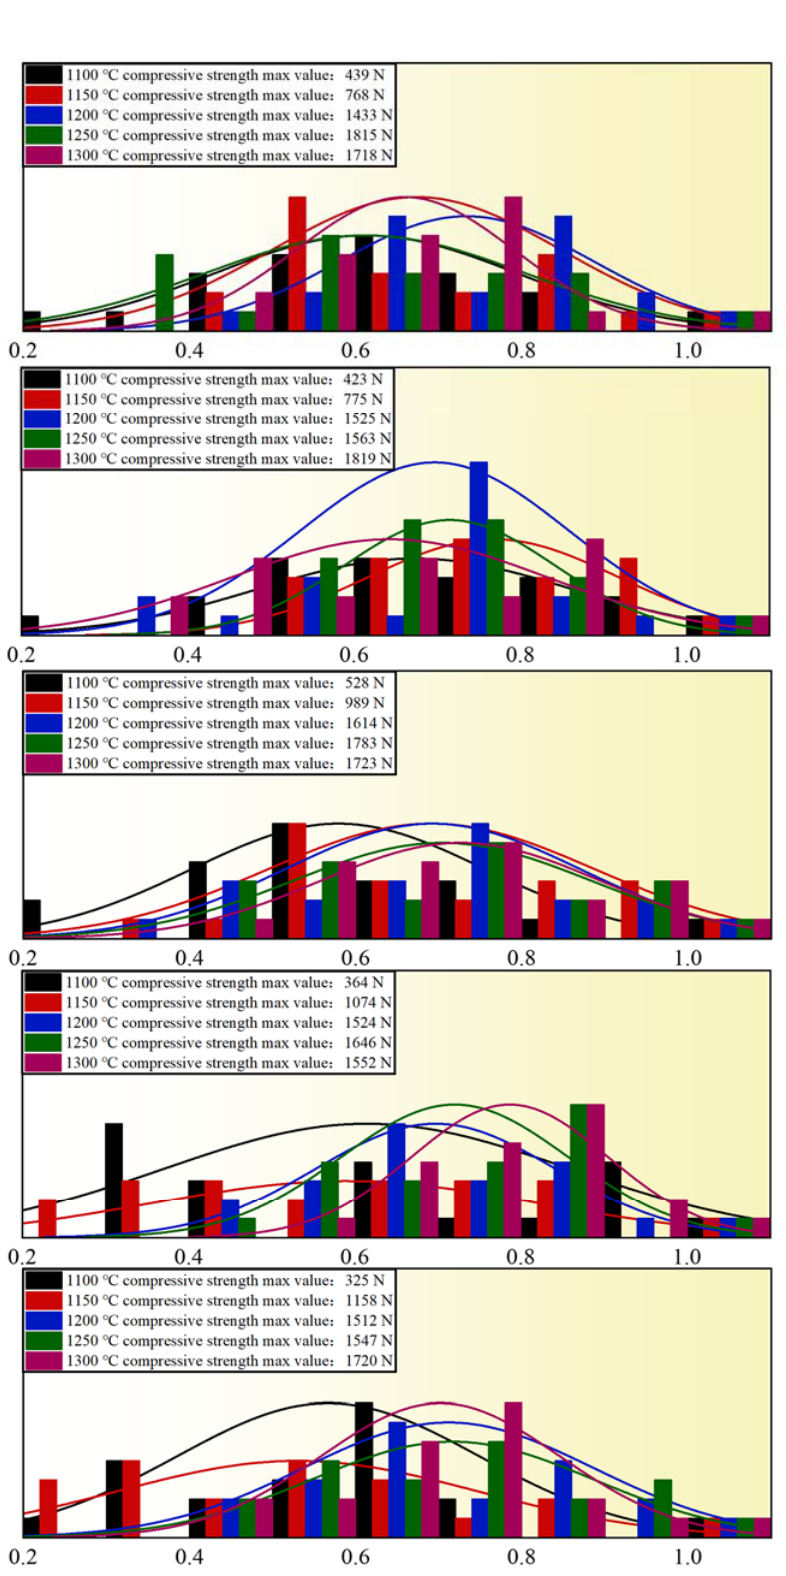
Figure 7. Effect of roasting temperature on the compressive strength of pellets.